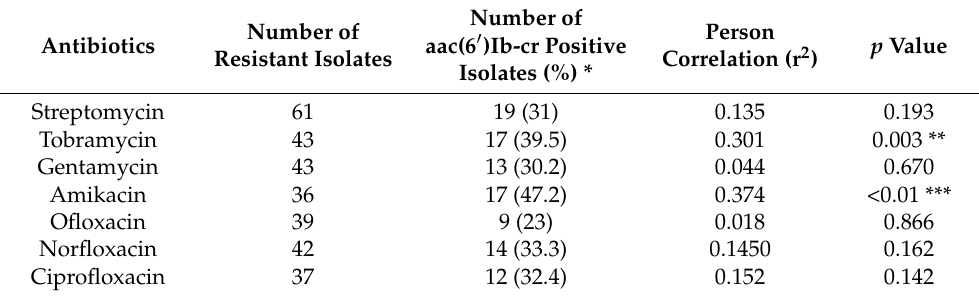
Table 7. Correlation between aac(6 (cid:48) )Ib-cr , aminoglycoside and fluoroquinolone